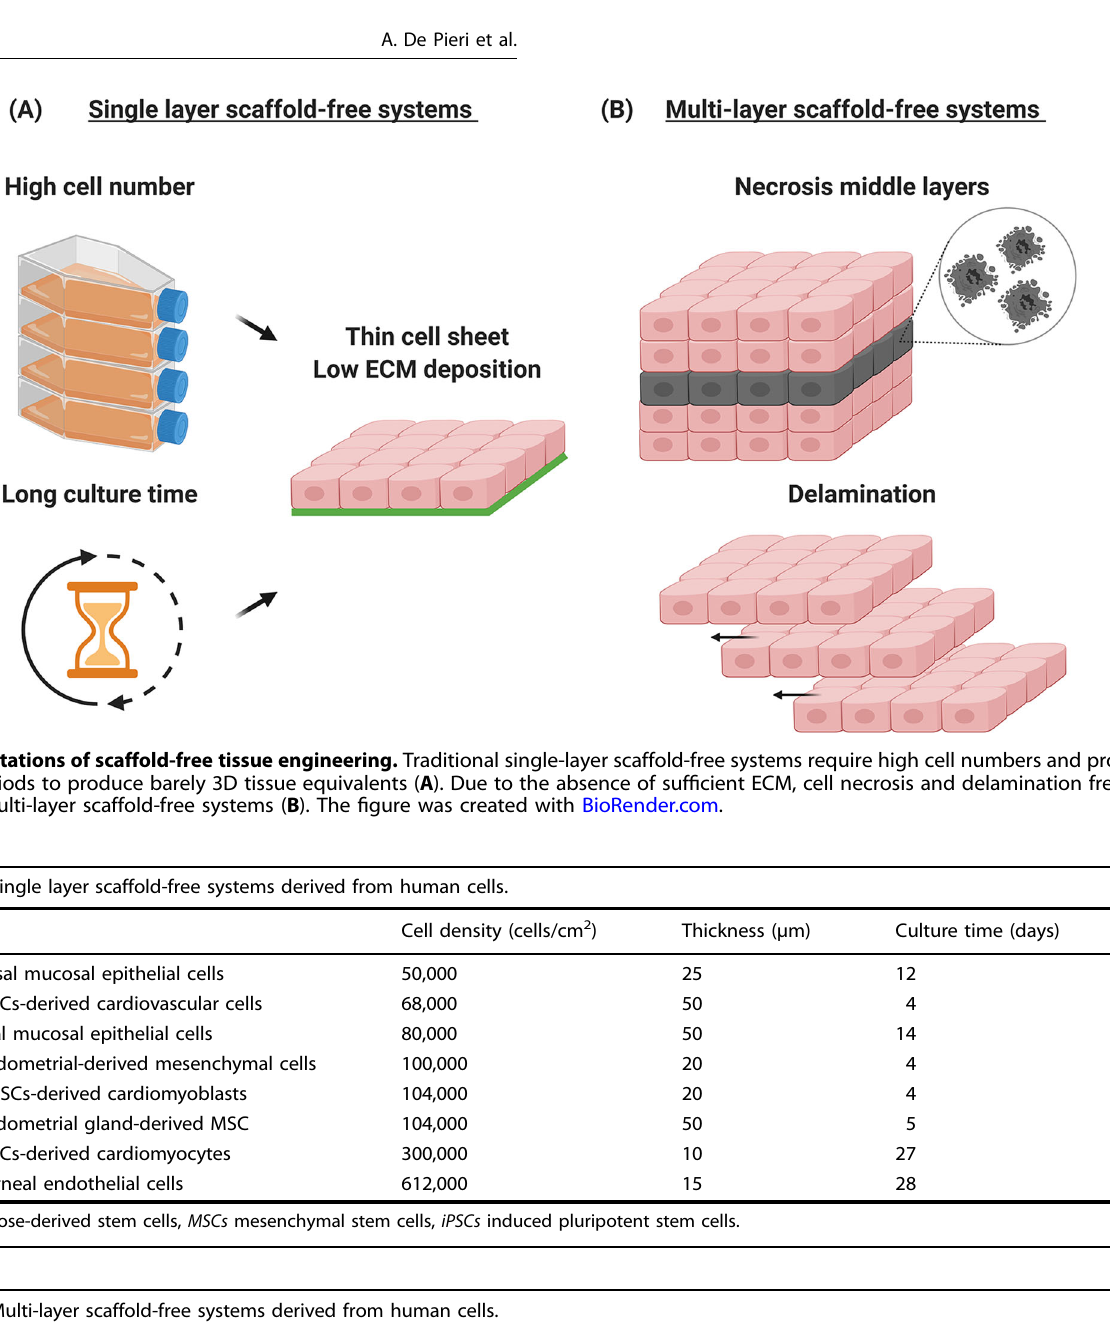
Table 6. Multi-layer scaffold-free systems derived from human cells.